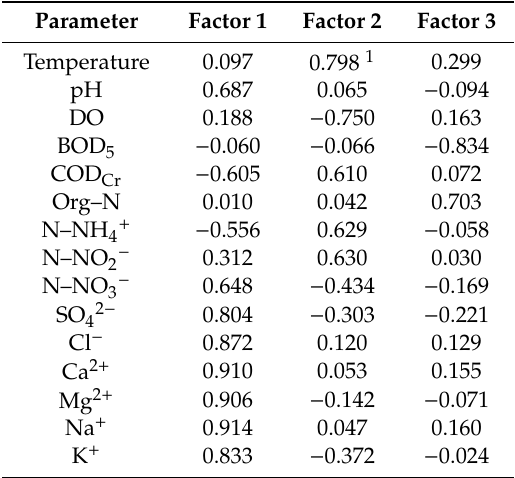
Table 5. The factor loadings for three selected factors.